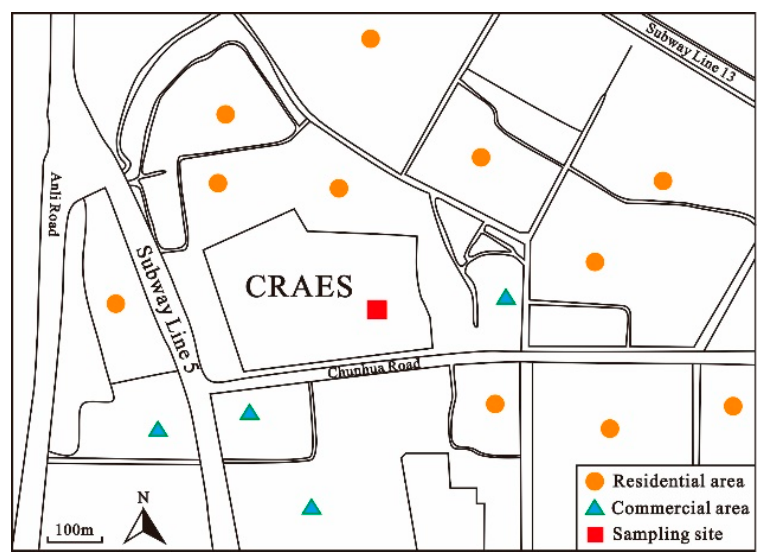
Figure 1. Sampling site location and its surrounding